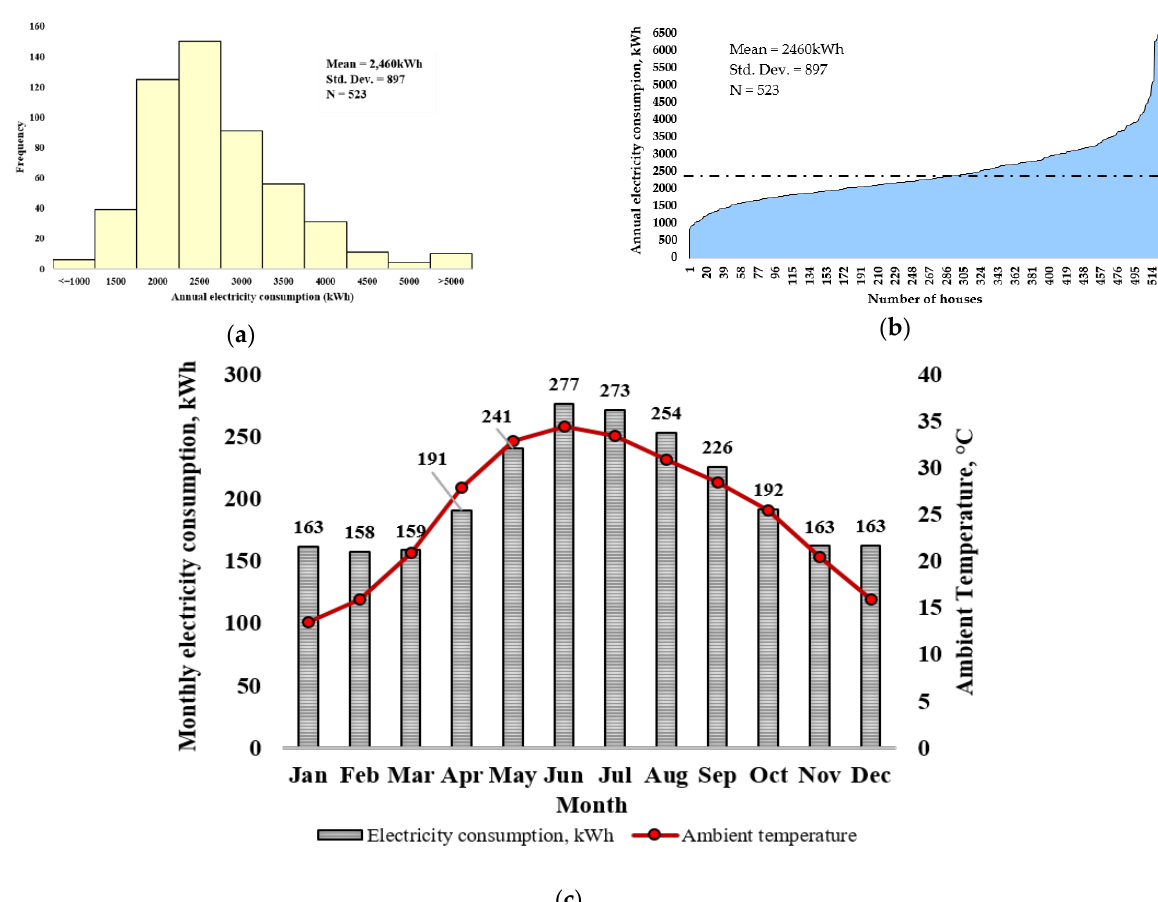
Figure 2. ( a ) Histogram of yearly electricity consumption. ( b ) Distribution of yearly electricity consumption. ( c ) Monthly electricity consumption Profile.